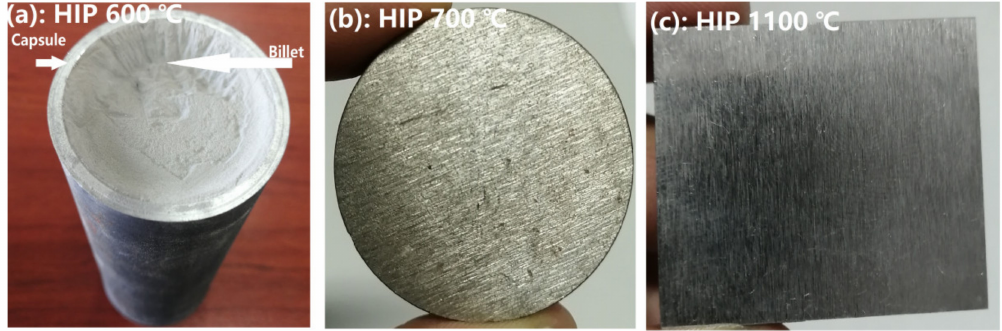
Figure 9. Temperature-dependent yield strengths of capsule material simulated by JMatPro Software.